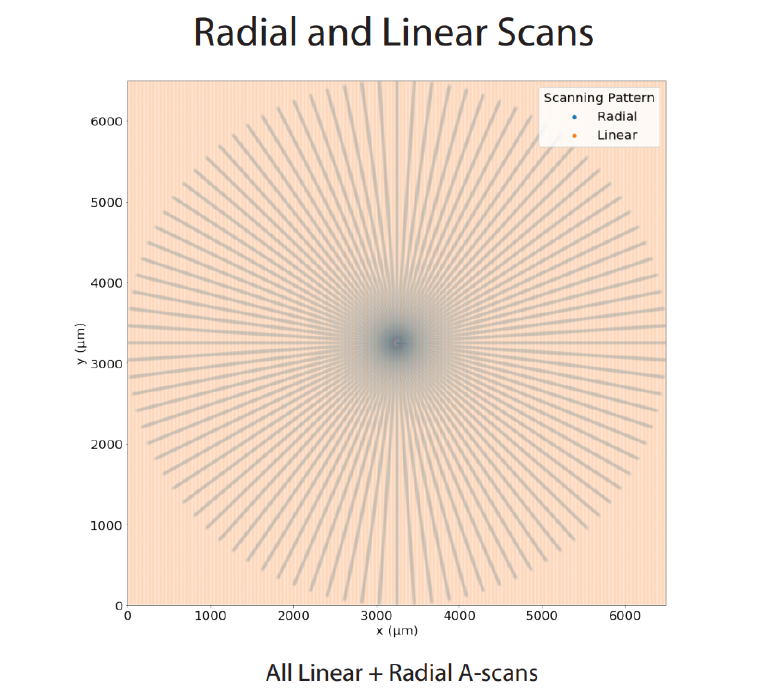
Figure 5. The registered A-scan view of both scanning